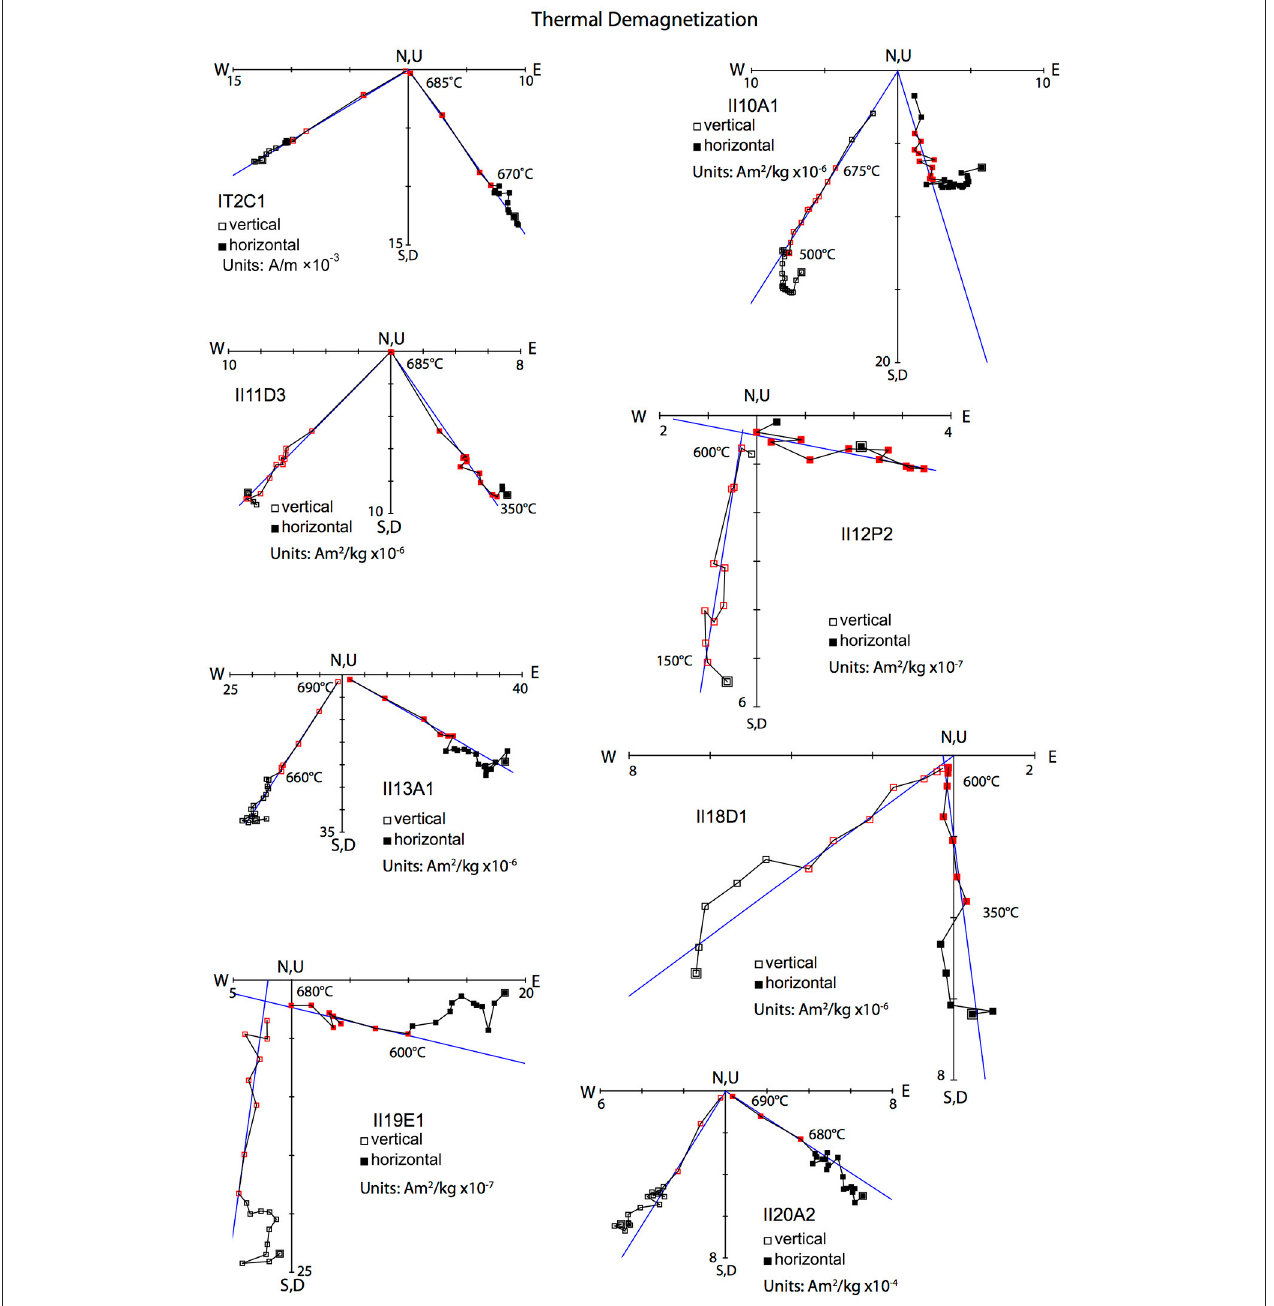
FIGURE 7 | Orthogonal thermal demagnetization diagrams of representative specimens from the sedimentary rocks of the Itararé Group. Solid (open) symbols represent projections on the horizontal (vertical) plane; red symbols are the demagnetization steps used for principal component analysis (PCA); blue lines are the PCA line-fits. See text for